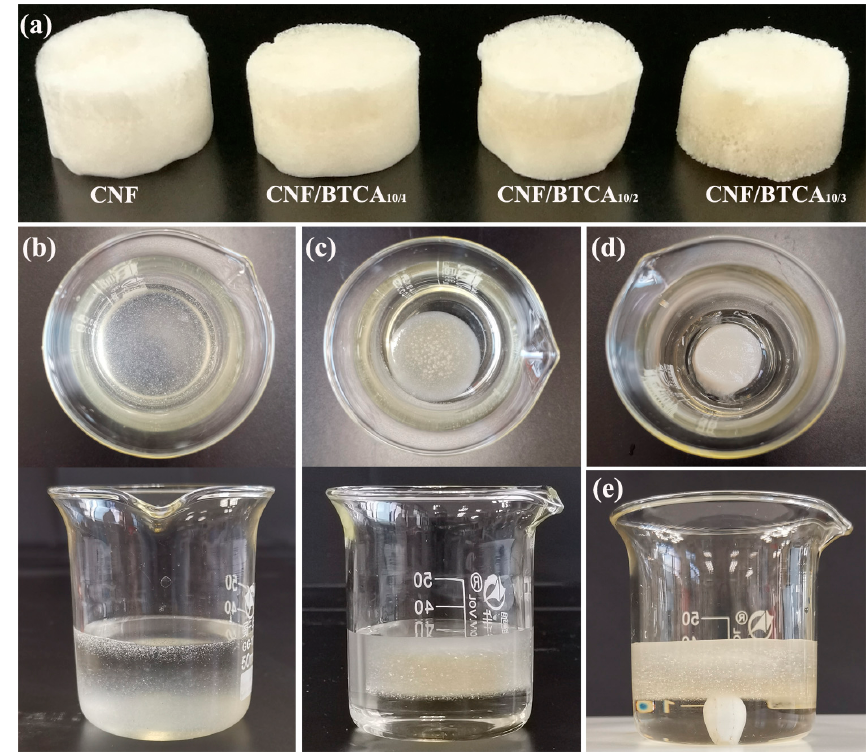
Figure 1. ( a ) Morphologies of the pure CNF, CNF/BTCA 10/1 , CNF/BTCA 10/2 , and CNF/BTCA 10/3 aerogels. ( b ) Photographs of the pure CNF aerogel disintegrated in water. ( c ) Photographs of the cross-linked CNF/BTCA 10/1 aerogel keeping intact in water. ( d ) The cross-linked CNF/BTCA 10/1 aerogel remaining intact after pouring out the excess water and ( e ) in stirring water.